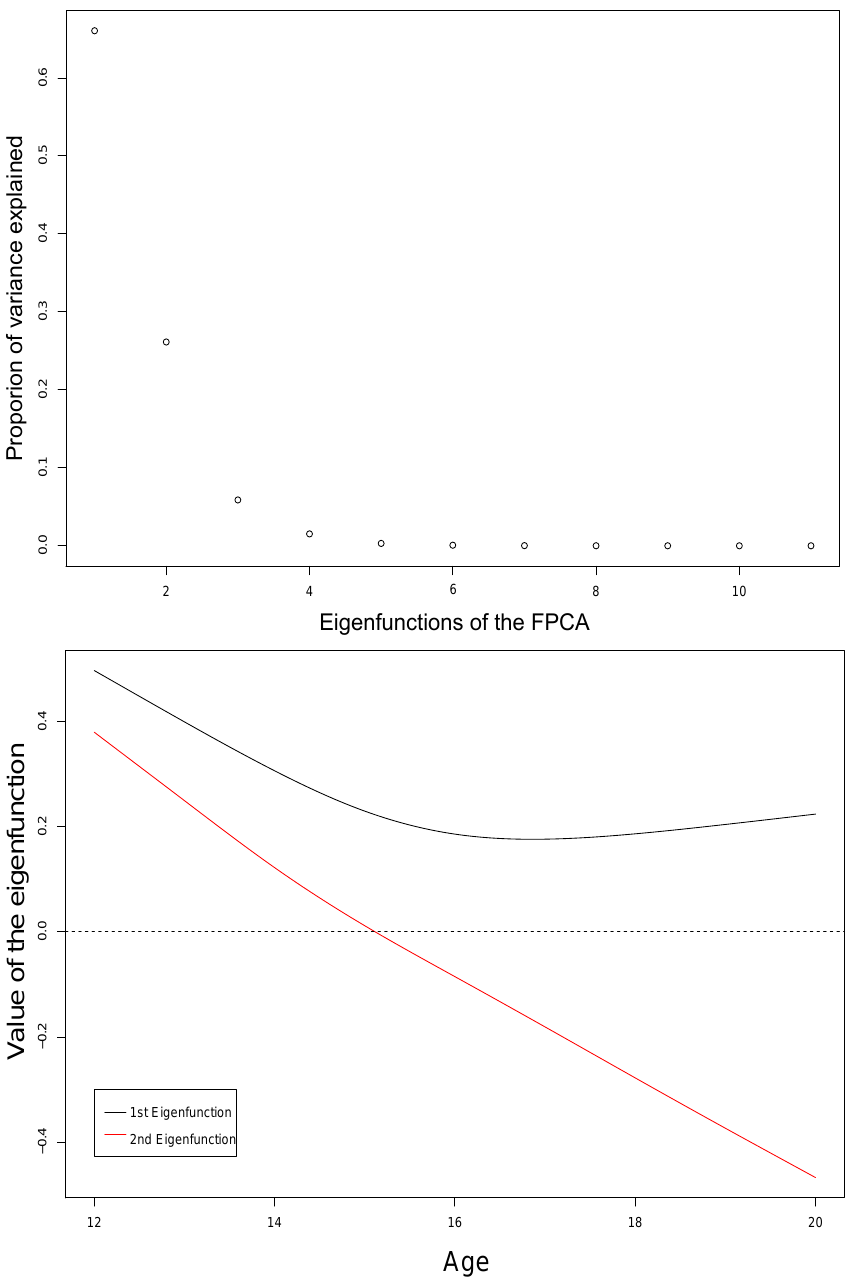
Figure A1. Results of the functional principal component analysis (FPCA) on the progression curves. ( Top ) proportion of variance explained by each eigenfunction. With only two eigenfunctions, one can express about 90% of the total variance of the data set; ( Bottom ) values of the two first eigenfunctions. Eigenfunctions are orthogonal to each other and display the main modes of variation of the curves. The first eigenfunction mainly informs about differences at young ages, while the second focuses on the opposition between speeds at young and older